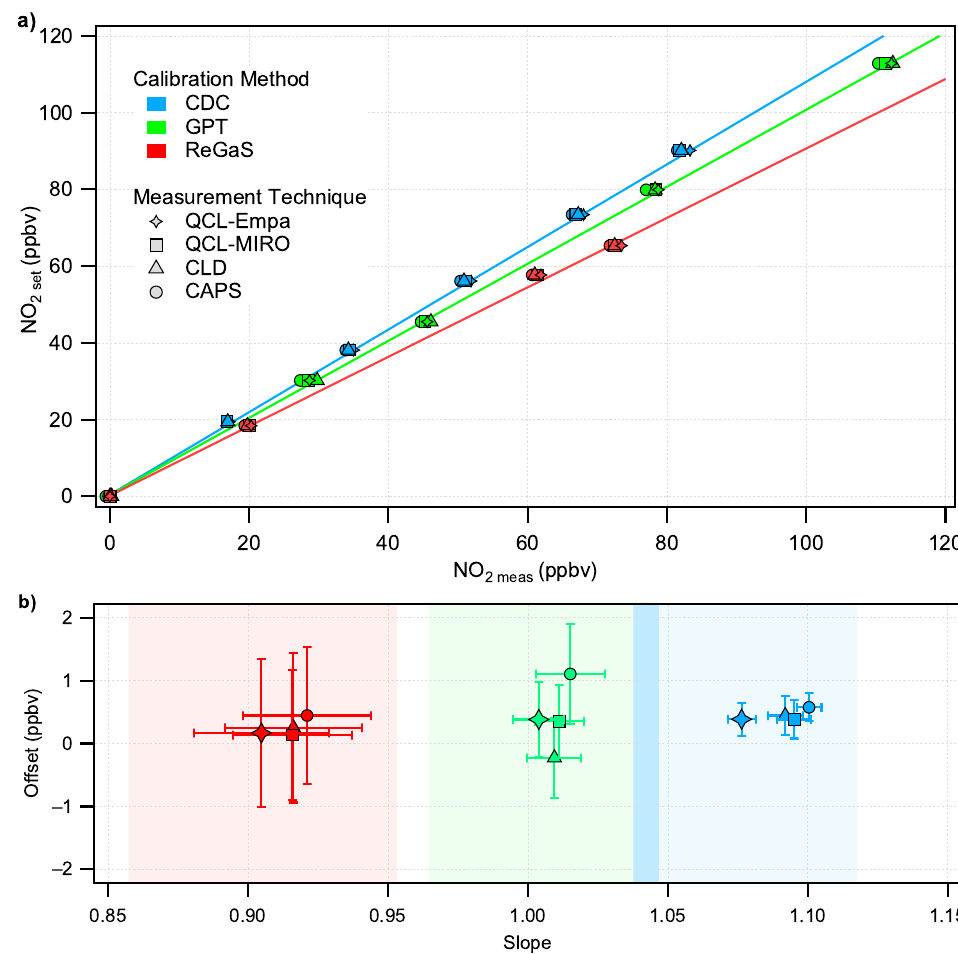
Figure 7. Calibration results: ( a ) Set versus measured NO 2 amount fractions for the four instruments and the three different calibration methods deployed. The colored lines show the least squares linear regression for the QCL-Empa instrument. ( b ) Summary of the intercepts and slopes of the linear fit of the data in ( a ). The error bars represent the 2 σ uncertainties of the fit. The width of the colored area represent the combined uncertainty of the fit and of the set span NO 2 concentration for the QCL-Empa calibration (k =